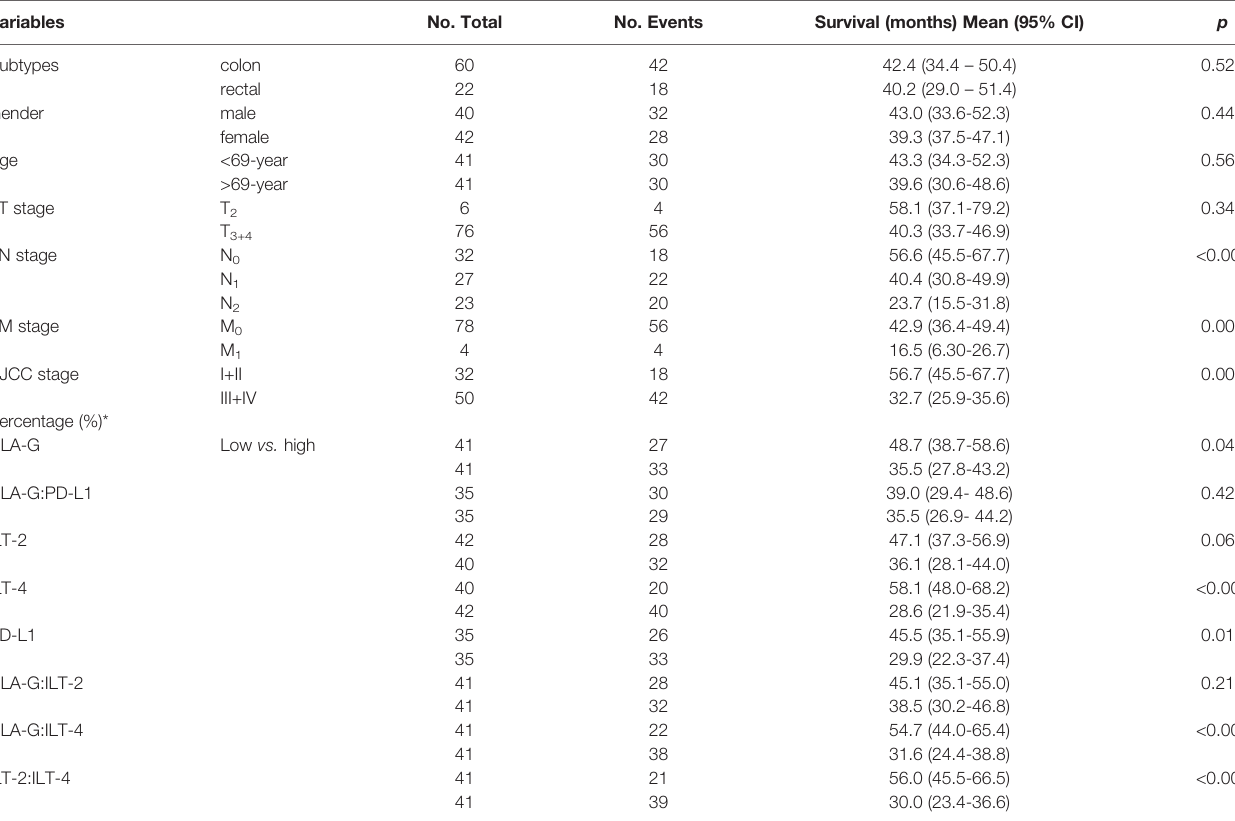
TABLE 2 | Kaplan-Meier log-rank analysis of variables for CRC patient survival.